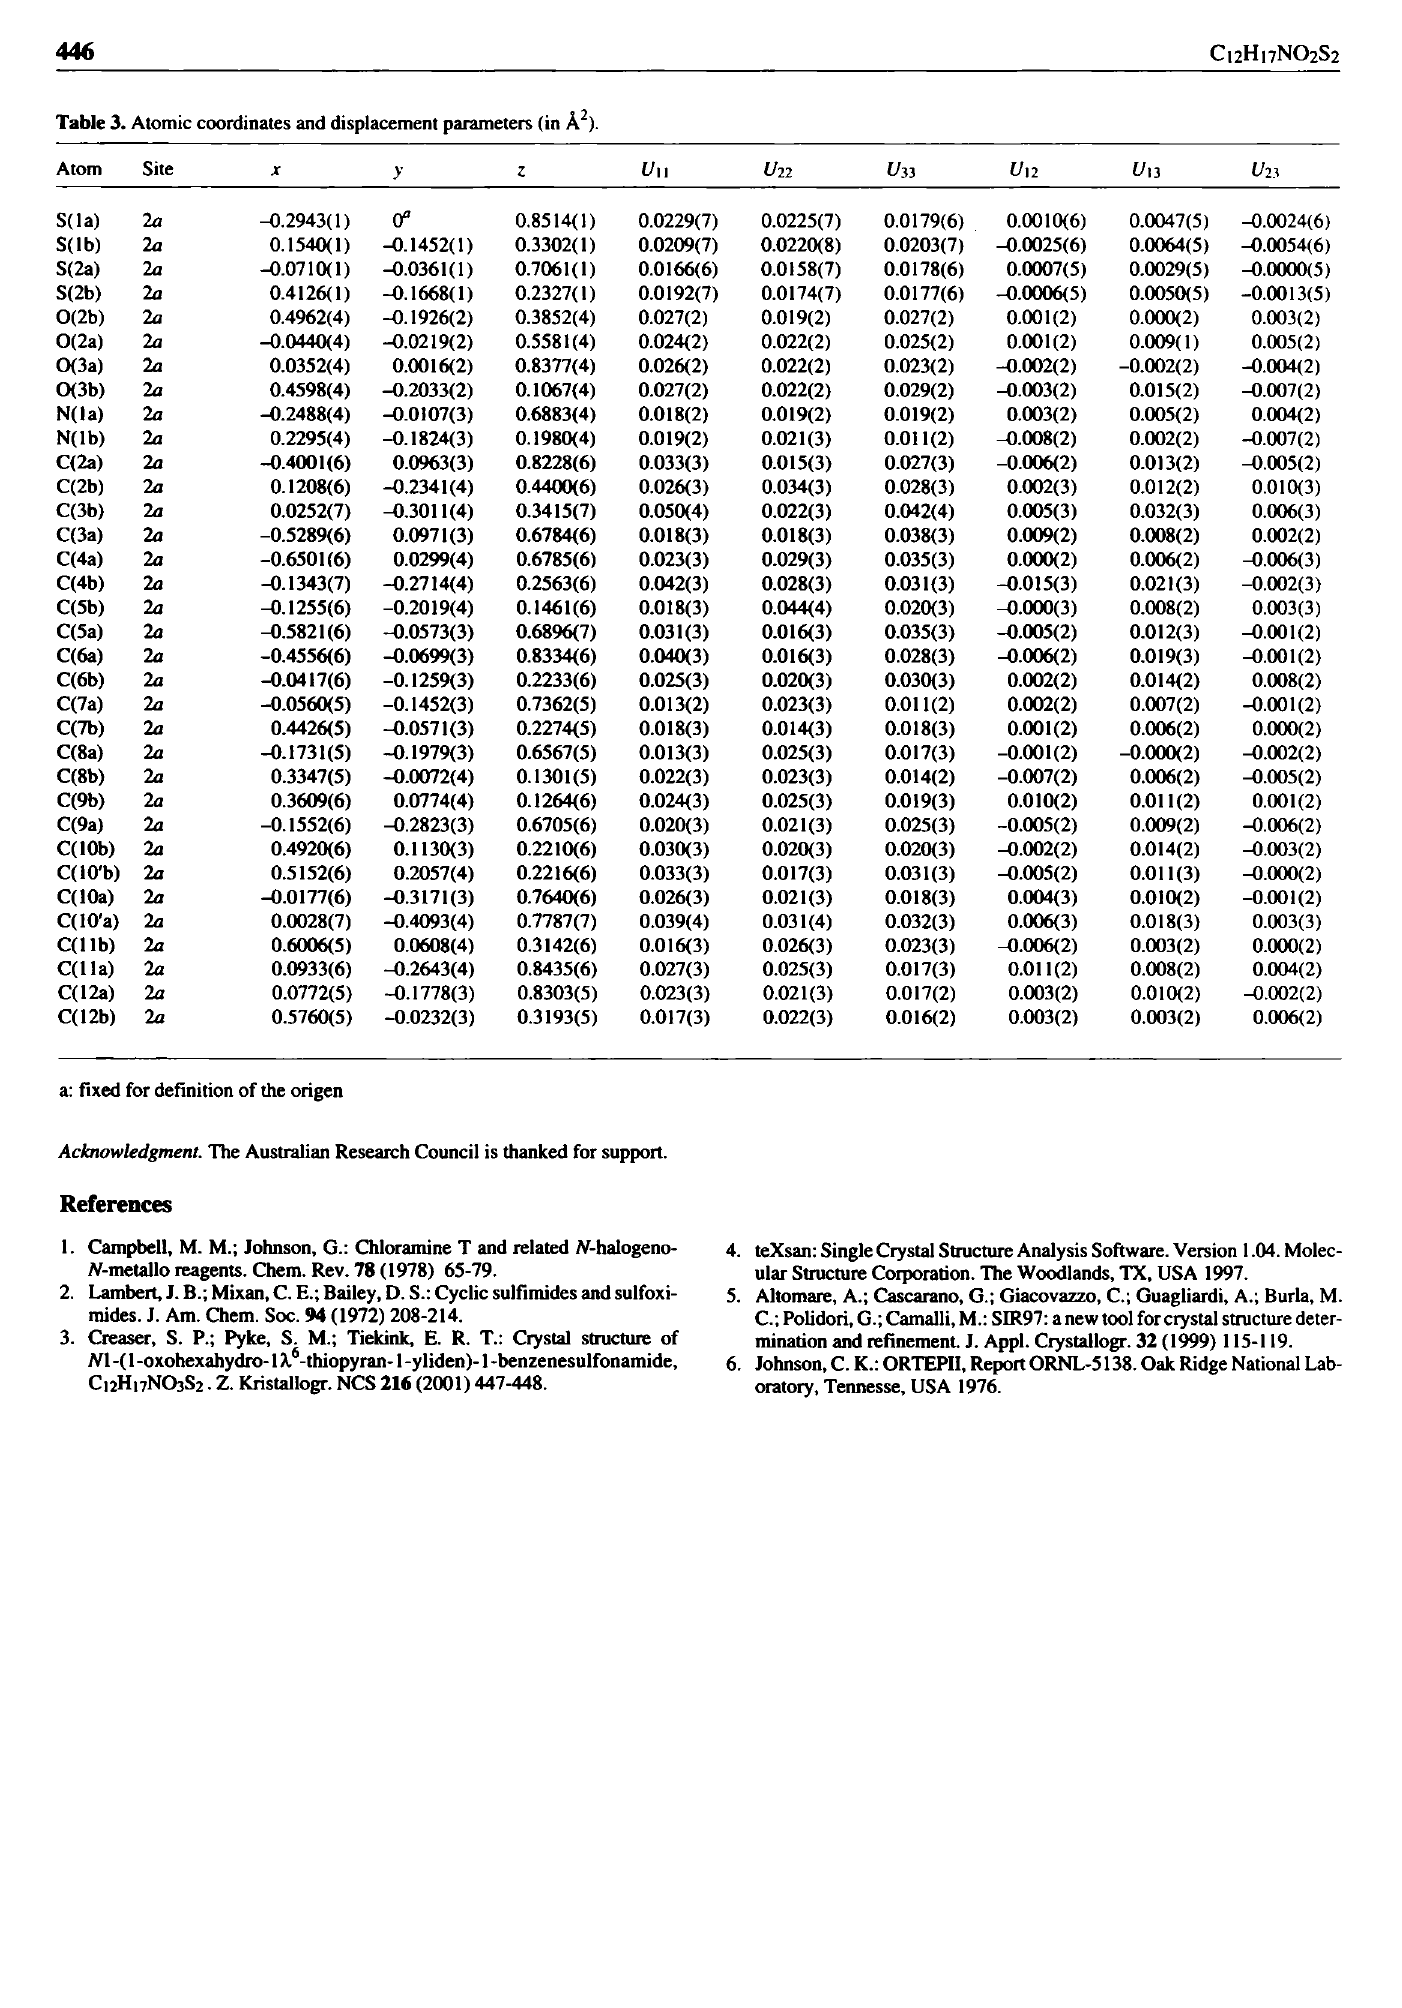
Table 3. Atomic coordinates and displacement parameters (in A 2